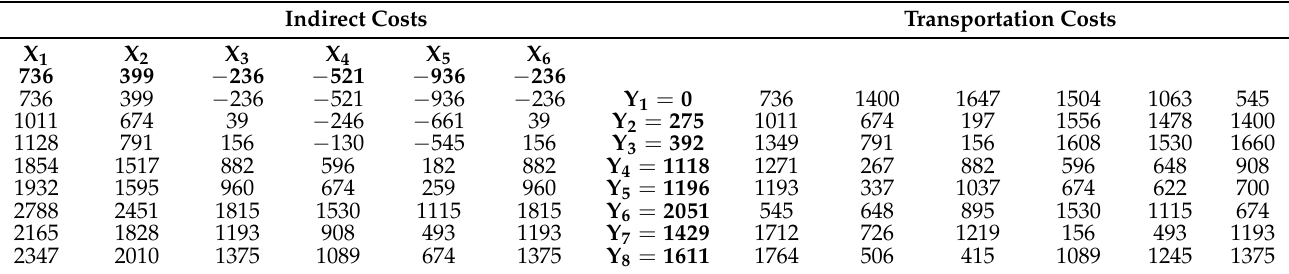
Table 10. Summary of indirect costs and costs resulting from task content.